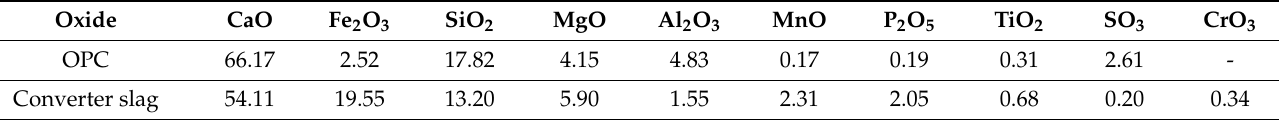
Table 1. Chemical compositions of Ordinary Portland Cement (OPC) and Converter slag (%).